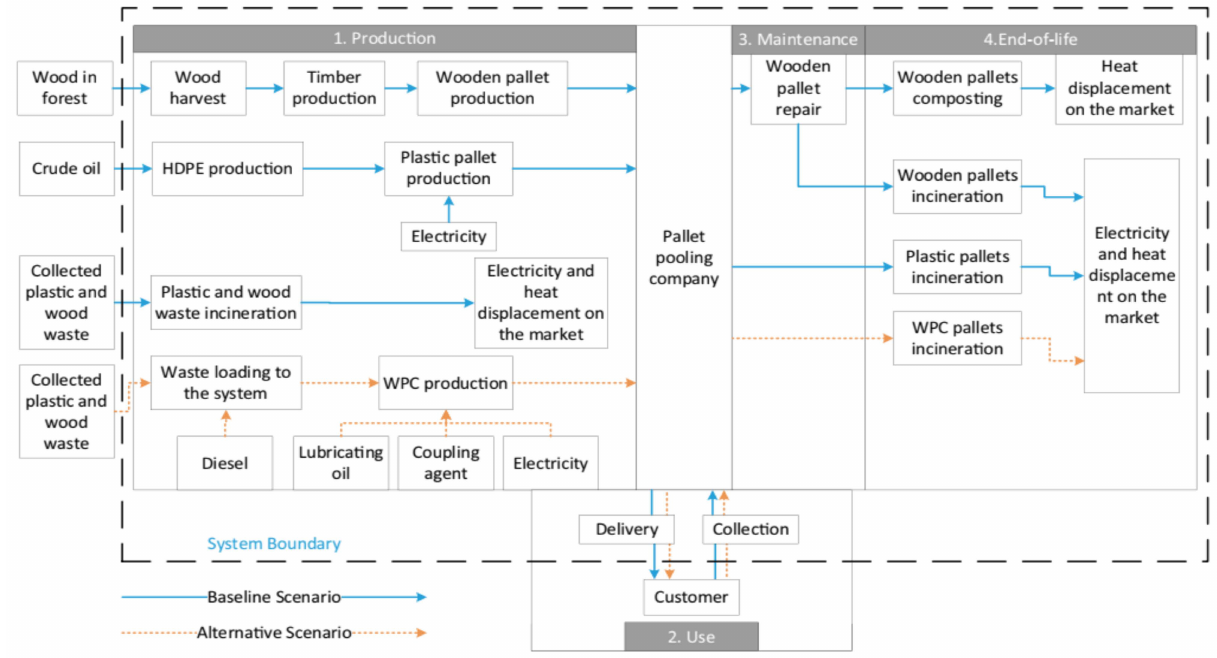
Figure 7. Scope of CLCA studies, Reproduced from [271], Springer,